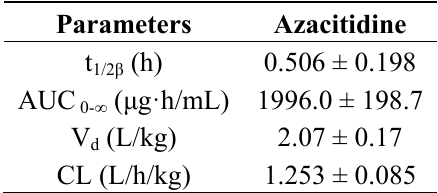
Table 4. Main pharmacokinetic parameters of azacitidine in rats following intravenous administration at a dose of 2.5 mg/kg (mean ± SD, n =